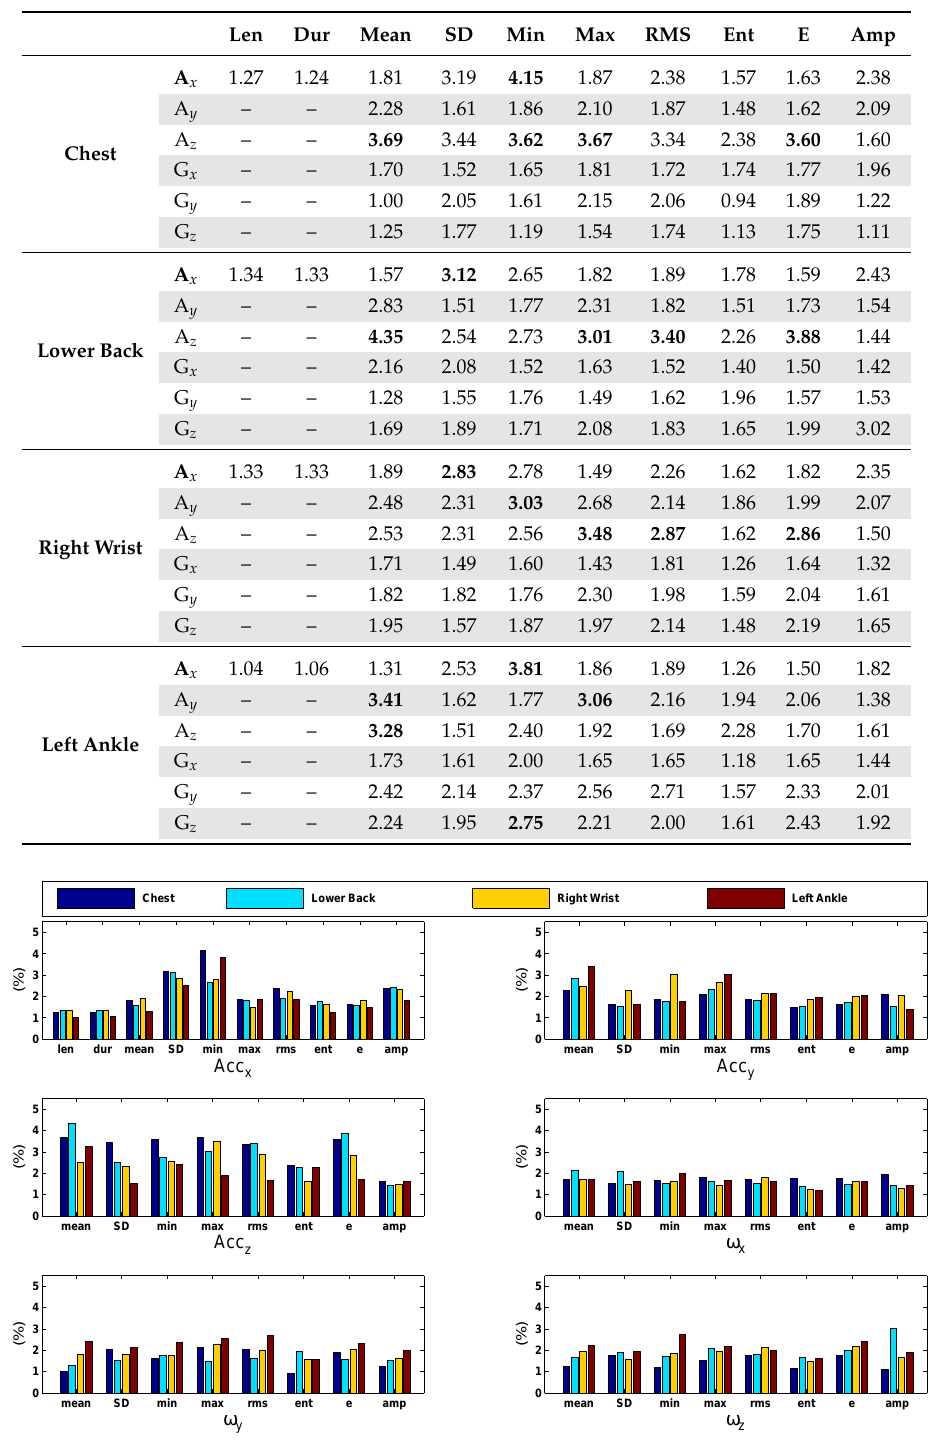
Figure 7. Bar graphs of the features’ importance computed during body height classification using the 10-fold cross-validation strategy. The graphs present a comparison of the importance of each feature (in %) with respect to different sensor positions. In general, all features are significantly contributing in the classification